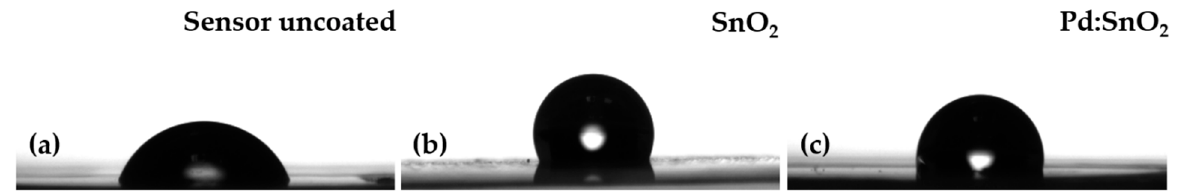
Figure 7. Contact angle images for ( a ) the uncoated working electrode, ( b ) the working electrode